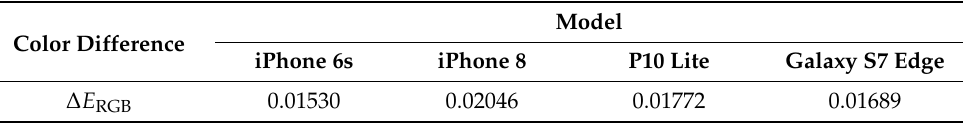
Table 2. Average color differences between the imaged colors of the 24 color checkers captured by each camera and the simulated colors based on the measured spectral